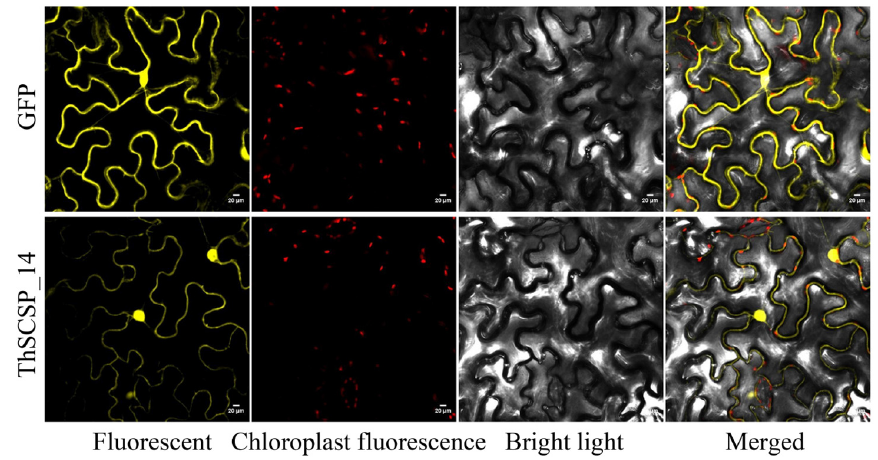
Figure 6. Subcellular localization of ThSCSP_14 transiently expressed in Nicotiana benthamiana leaves. The vector PHB carrying GFP was the control. ThSCSP_14 and GFP fluorescence signals were visualized using laser confocal fluorescence microscopy at 48 h after infiltration and were de- picted in yellow. The red dots denoted the chloroplast channel. The white scale bars represented 20 μ m.